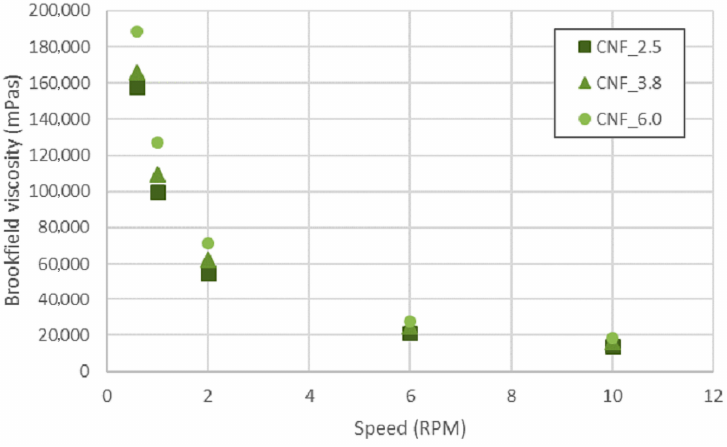
Figure 2. Brookfield viscosity assessment, measured at various speeds.